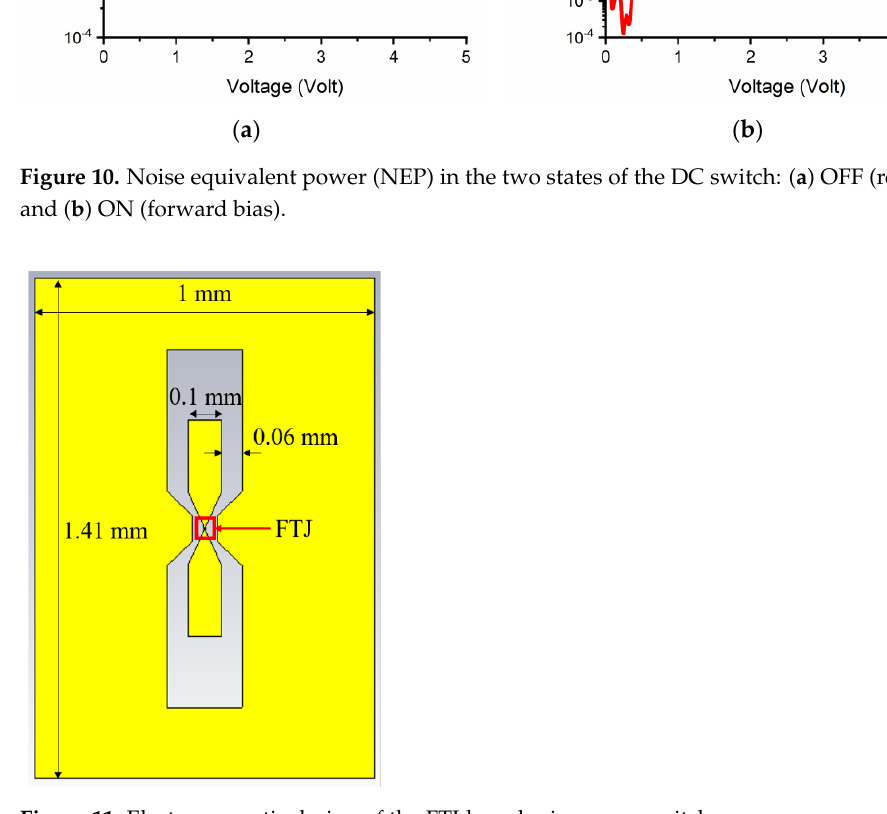
Figure 11. Electromagnetic design of the FTJ-based microwave switch.